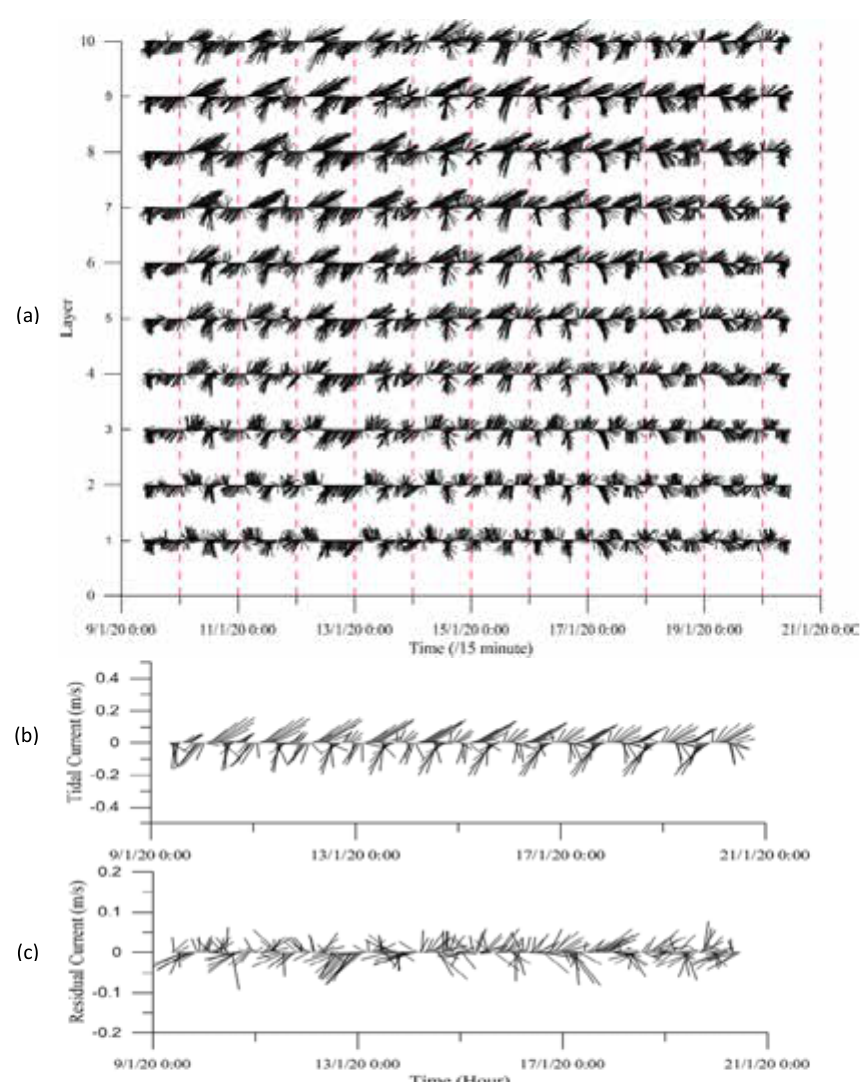
Fig. 2: Water current profile at ten layers (a); the separation of the tidal current (b) and residual current (c) components averaged to depth.